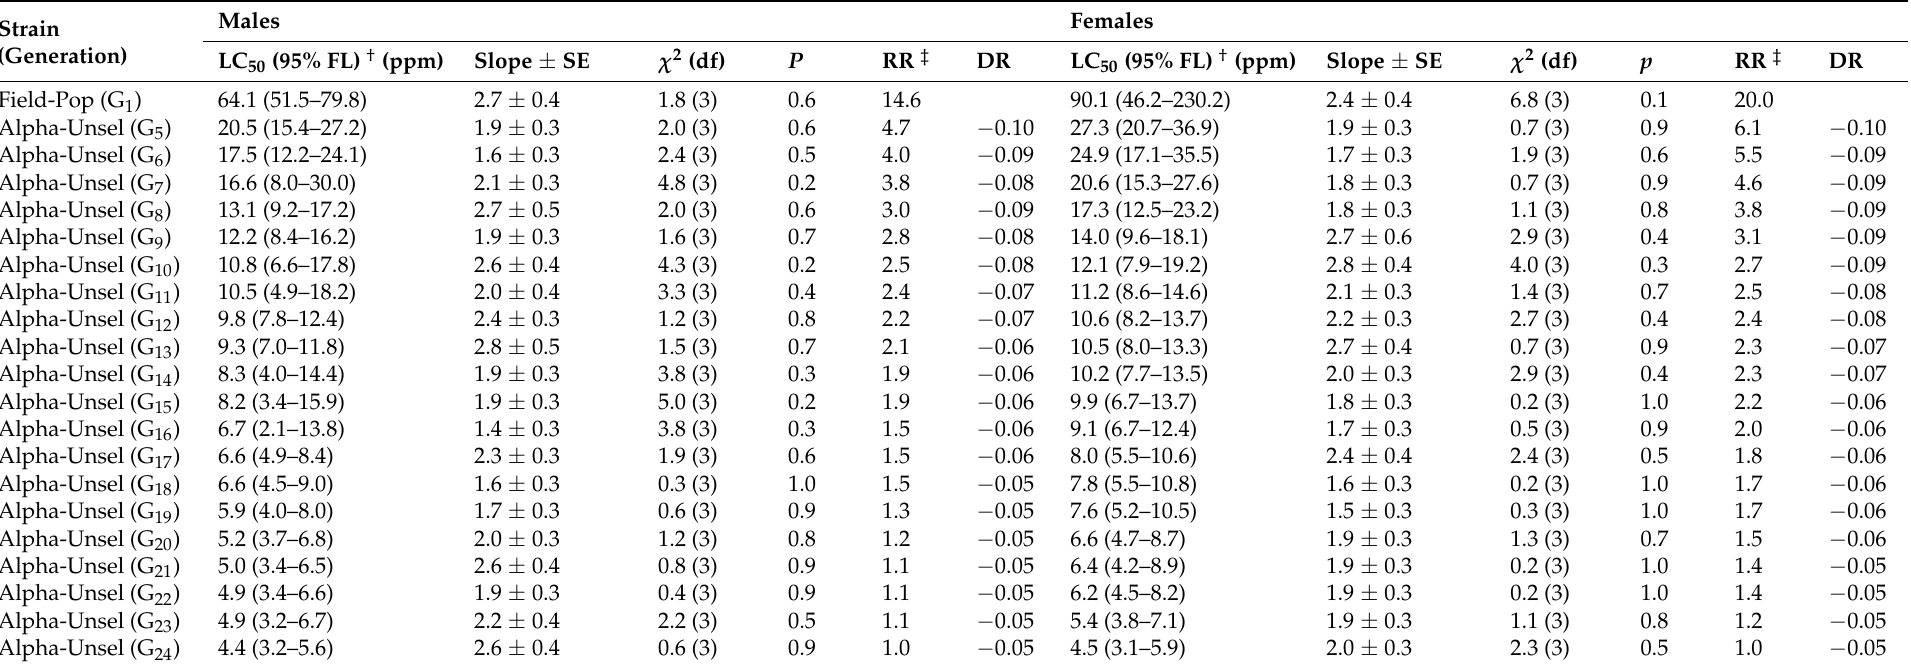
Table 4. Stability of alpha-cypermethrin resistance in a field strain of Musca domestica